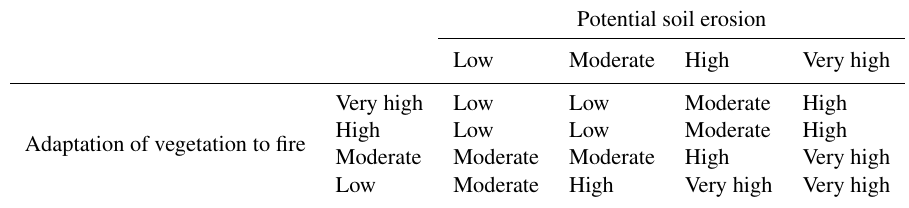
Table 8. Criteria for assigning ecoregions to the different post-fire vegetation regeneration delay categories. Potential soil erosion Low Moderate High Very high Very high Low Low Moderate High High Low Low Moderate High Adaptation of vegetation to fire Moderate Moderate Moderate High Very high Low High Very high Very